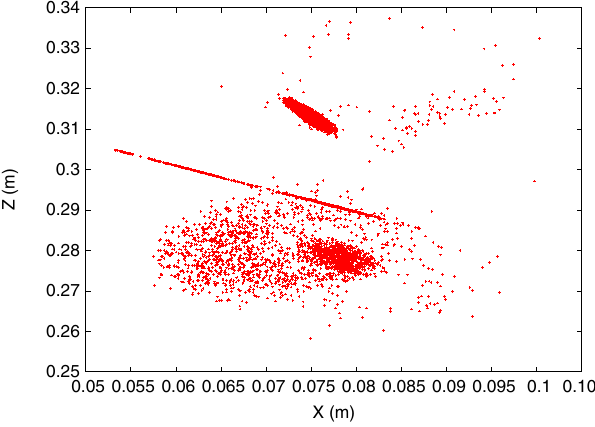
FIG. 13. X - Z view of the bottom aperture impact distribution for the three different injection spot positions described in Sec. II. The blue dots correspond to the design injection position, the green dots correspond to a move of the injection spot 7 mm beam left, and the red dots correspond to the final move of the injection position 5 mm downstream.